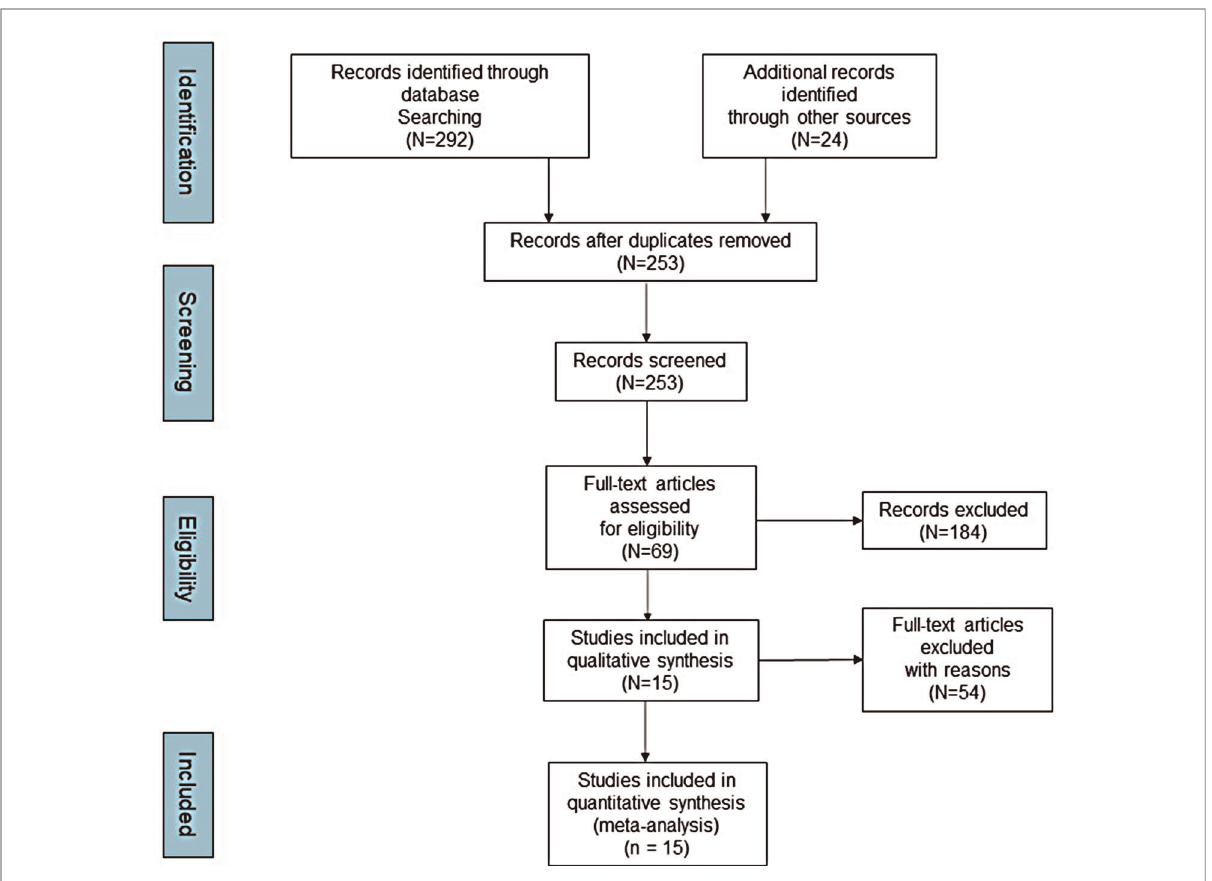
FIGURE 1 The processes of inclusion and exclusion